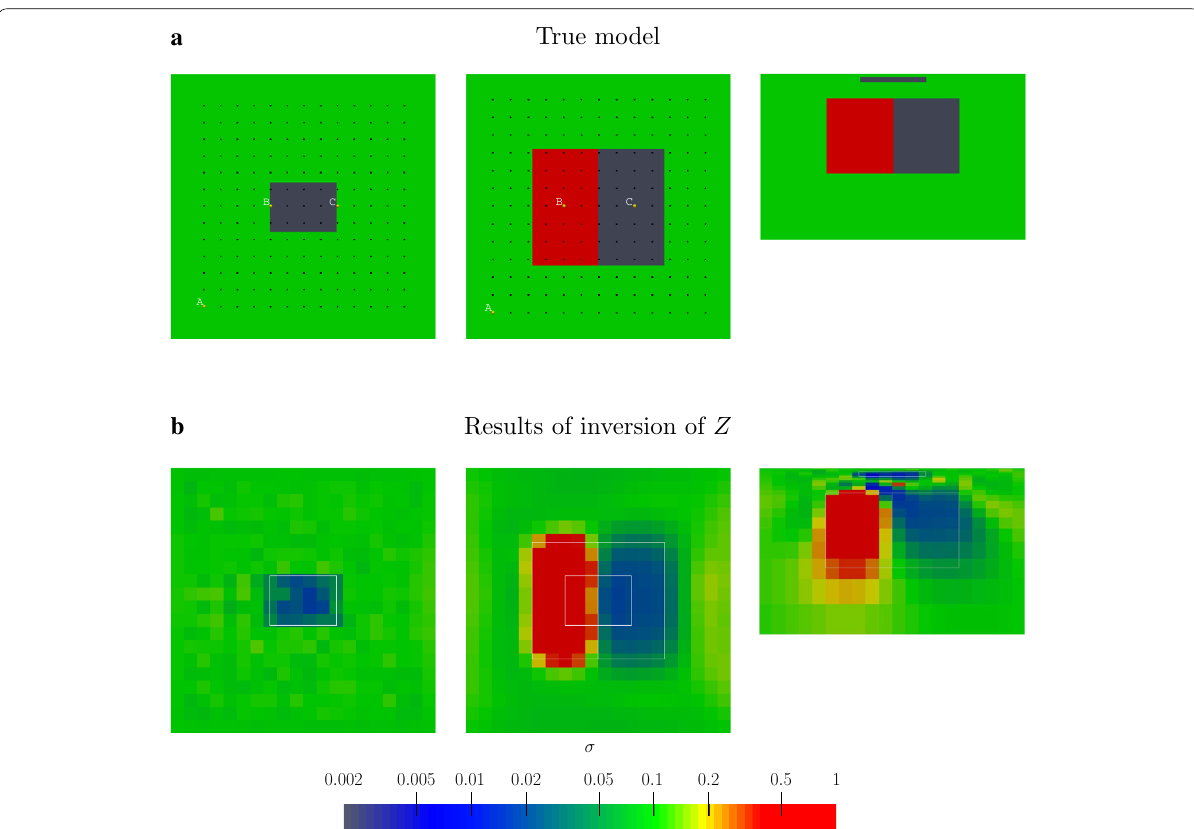
Fig. 1 Upper left and middle plots show plane view of the model at depths 300 and 2500 m, respectively. Upper right plot presents the side view of the model. Side view is taken along central, y -directed, cross section, where x - and y -axes are pointed up and right, respectively, at “plane view” plots. Locations of survey sites are depicted by black dots in the plane view plots. Yellow dots in the same plots (denoted as A, B, C) stand for the locations of the reference site. Note that the reference site is only involved in the inversion of inter-site responses. Bottom plots show the model recovered by inversion of (single-site) impedances tensor Z . The results are shown through the same cross sections shown in upper plots. White lines depict the boundaries of the true model